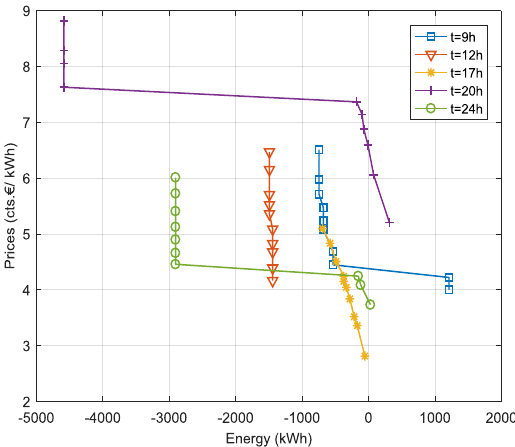
Figure 5. Optimal bidding curves to buy energy in the intraday market.